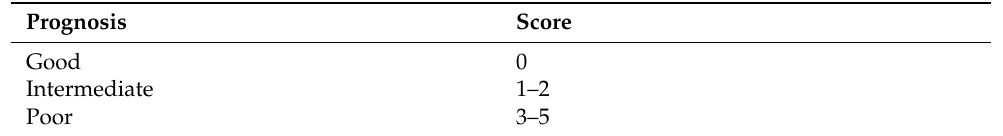
Table 4. Definition of prognostic criteria for International Metastatic RCC Databese Consortium (IMDC) and MSKK scores.